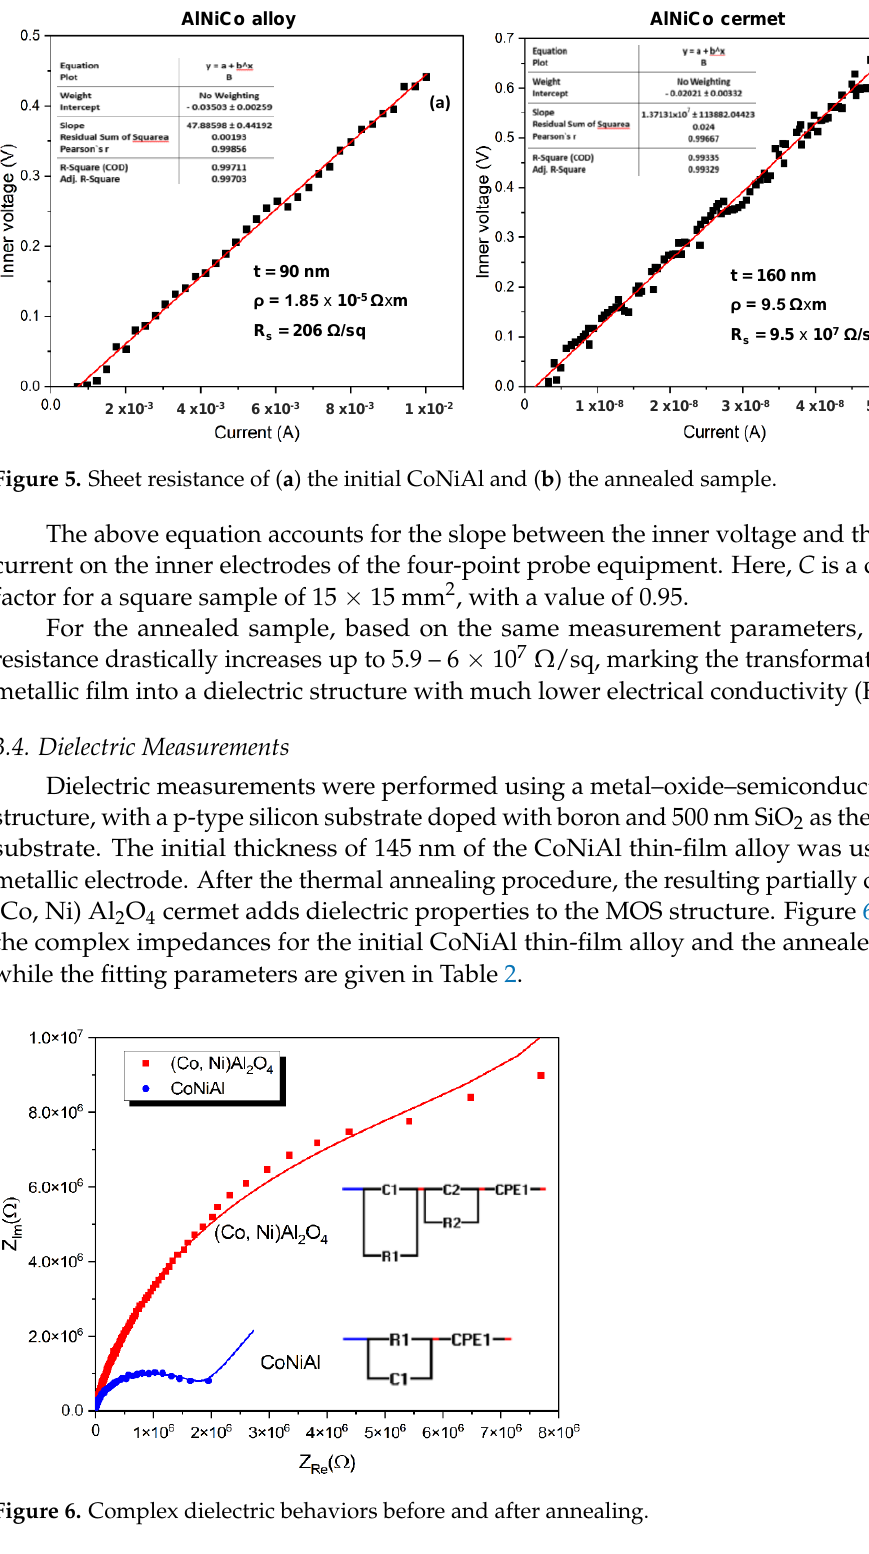
Figure 6. Complex dielectric behaviors before and after annealing.